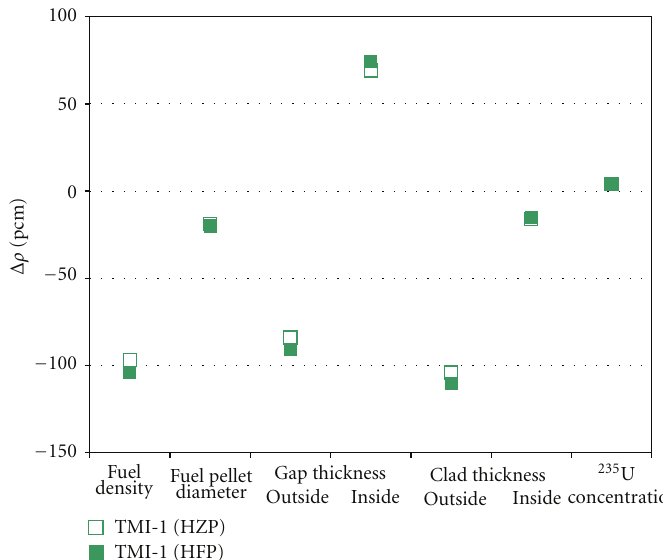
Figure 7: Manufacturing sensitivities for TMI-1 test case.